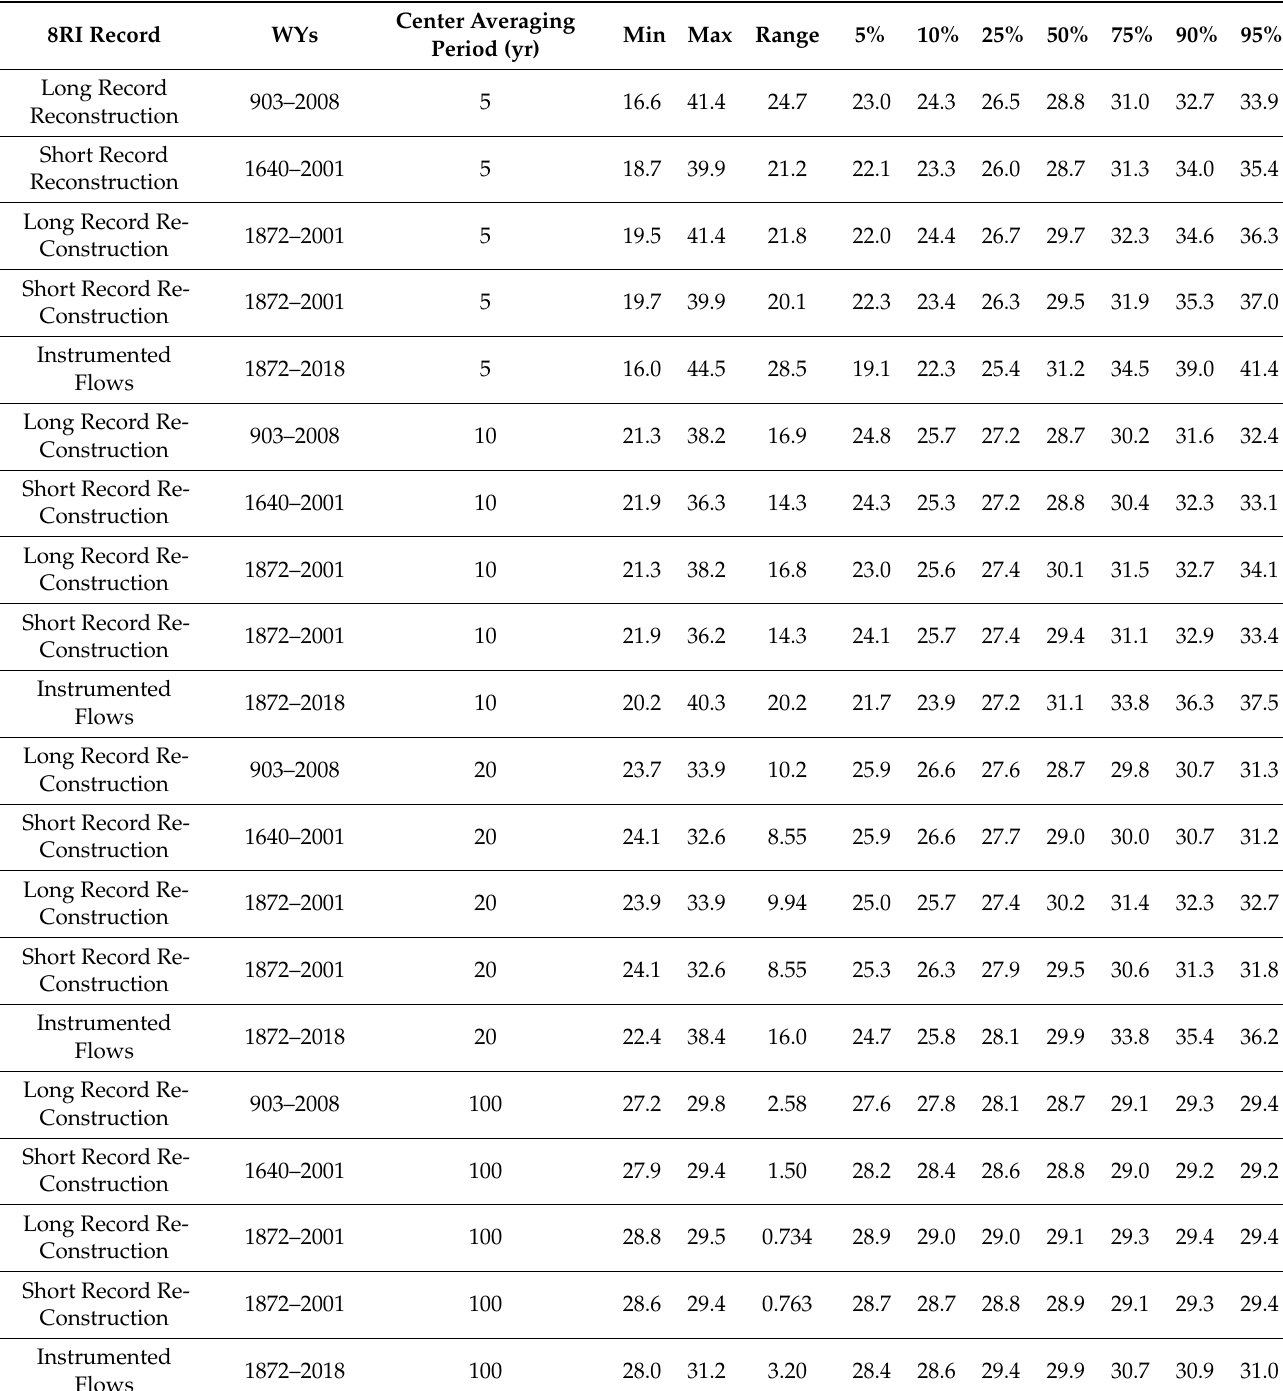
Table 4. Range of reconstructed and instrumented Central Valley Runoff (8RI) for different averaging periods. Units are reported as